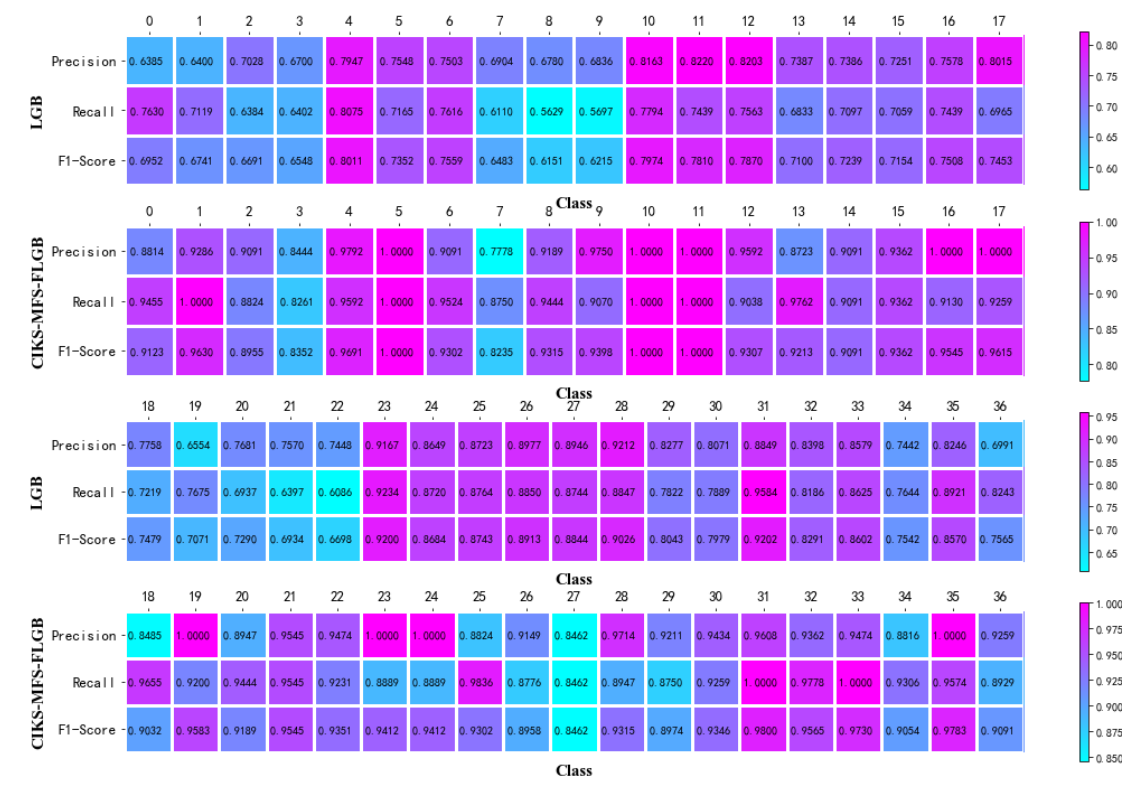
13 of 18 Table 2. Overall performance comparison. Algorithm/Model